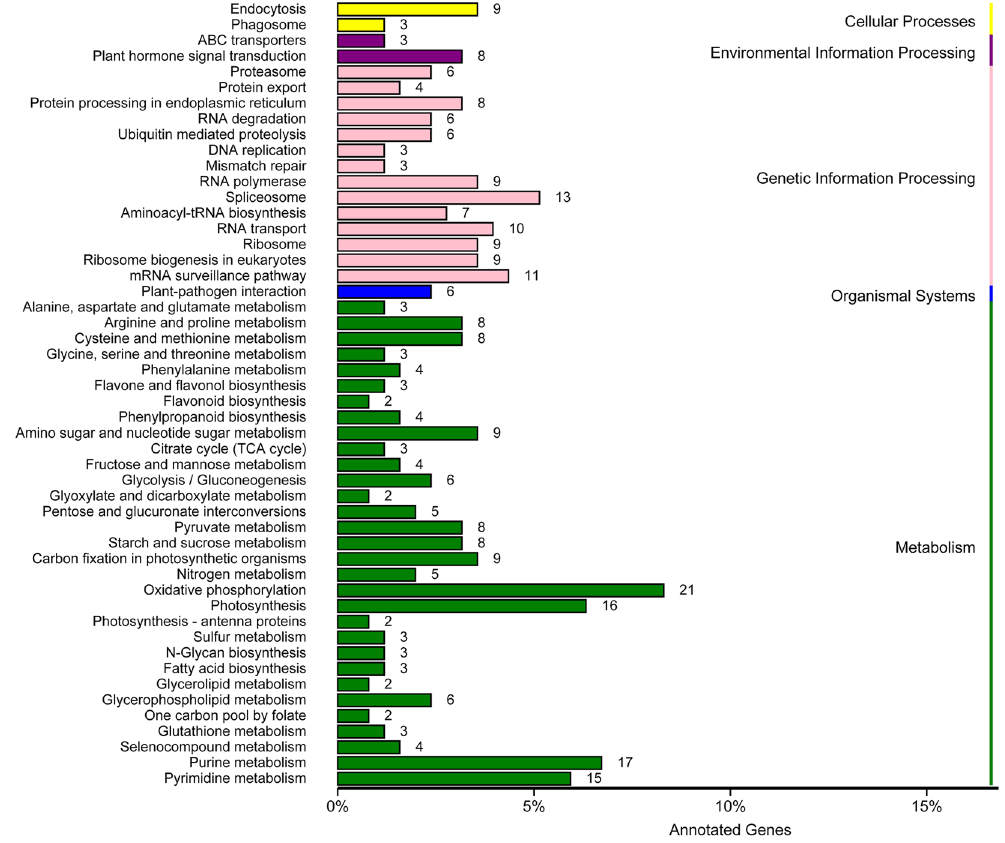
Figure 7. Kyoto Encyclopedia of Genes and Genomes (KEGG) enrichment analysis of WRKY target genes in D. officinale . KEGG pathway consists of graphical diagrams contained four main categories: ‘metabolism’ (green), ‘genetic information processing’ (pink), ‘environmental information processing’ (purple), ‘cellular processes’ (yellow) and ‘organismal systems’